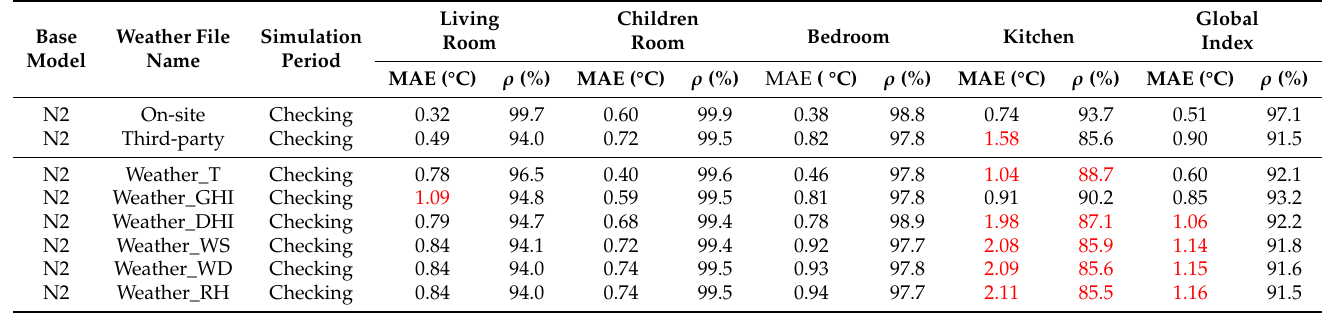
Table A4. MAE and ρ indices per thermal zone in the checking period. House N2, calibrated model.